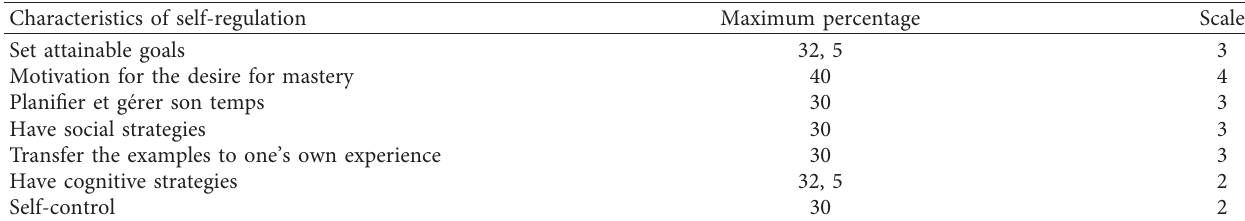
Table 3: Characteristics of self-regulation in students.